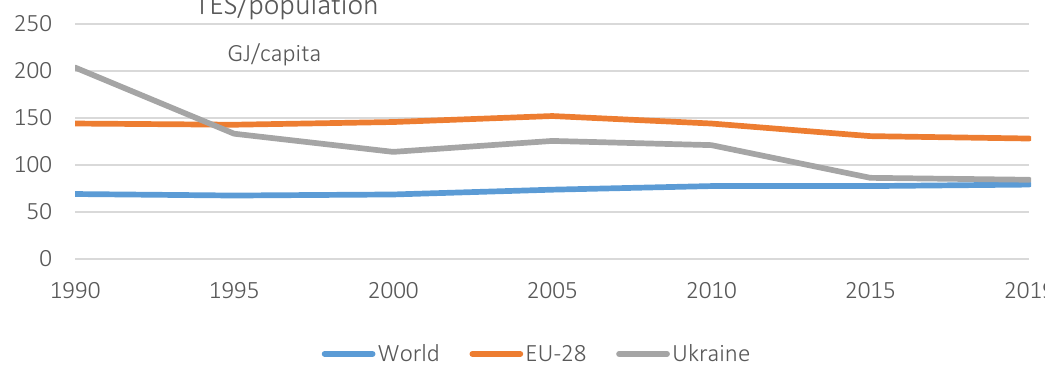
Figure 7. Total energy supply (TES) per capita